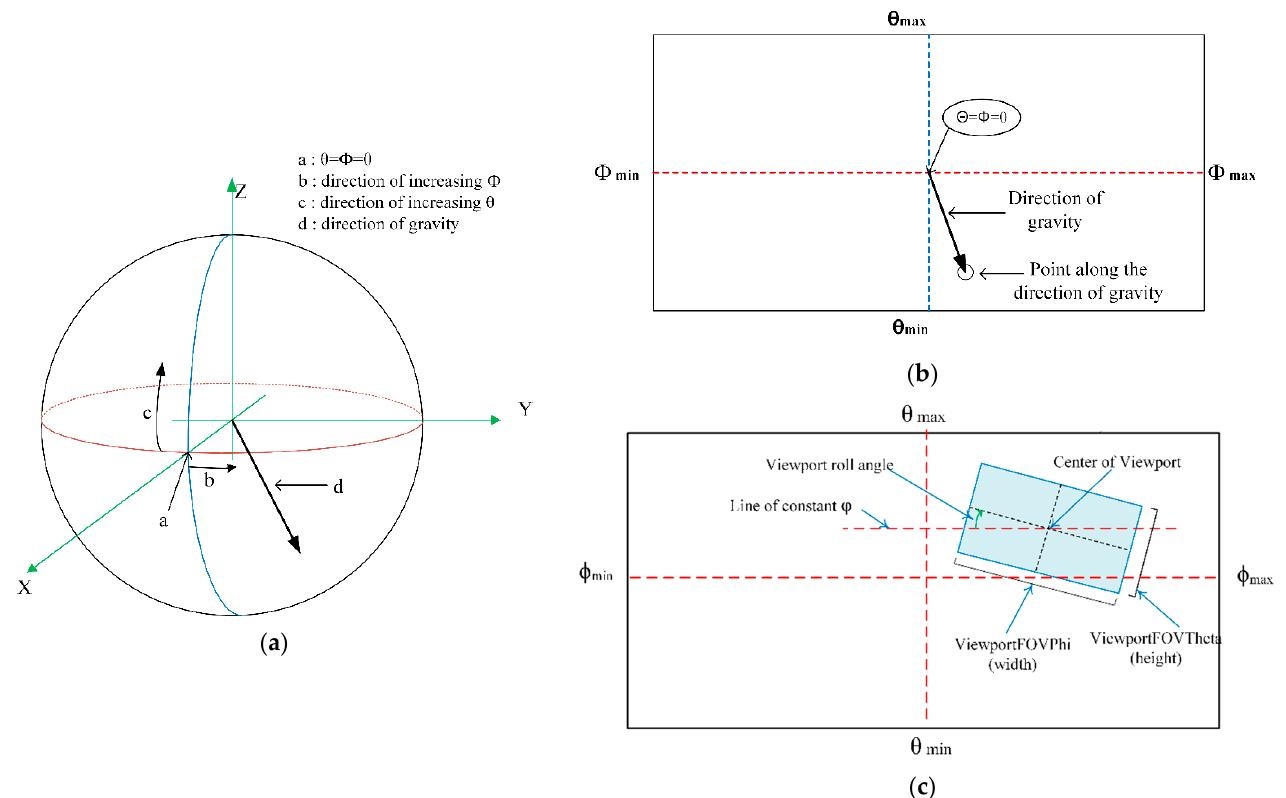
Figure 4. Graphical overview of ERP image: ( a ) spherical and cartesian coordinates, ( b ) generalized description of ERP mapped on 2D plane, and ( c ) generalized description of the viewport.